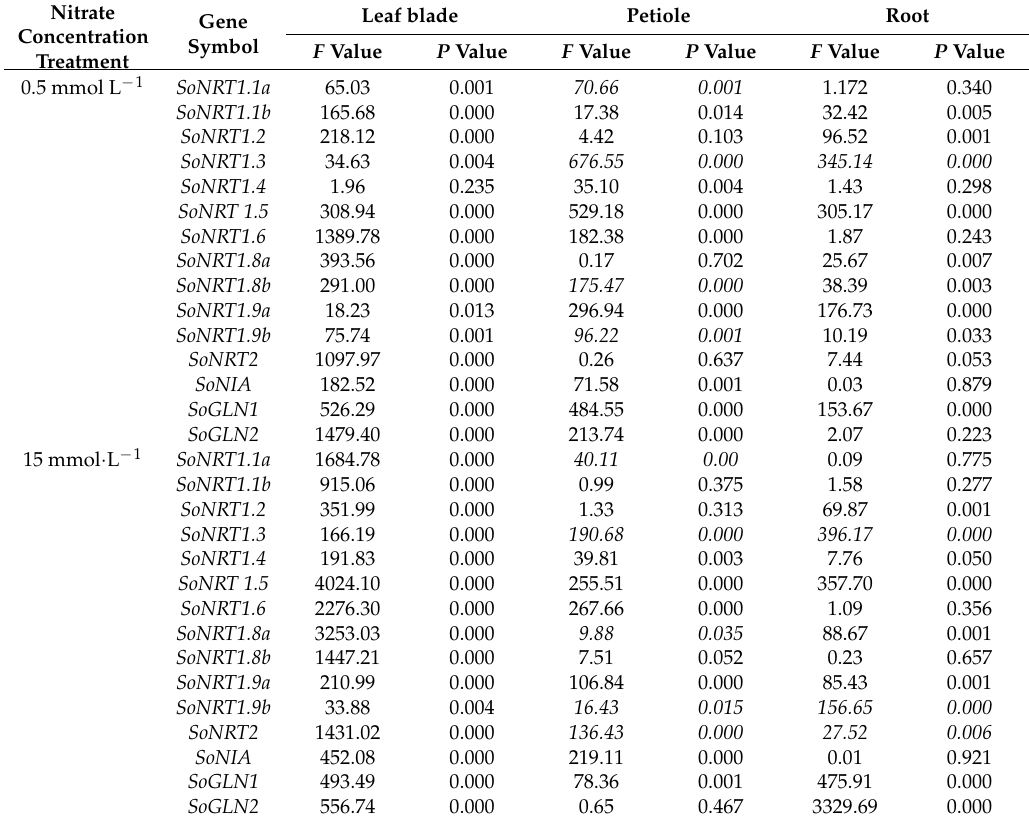
Table 1. Results of repeated measures ANOVA for the effects of varieties on gene expression. Nitrate Concentration